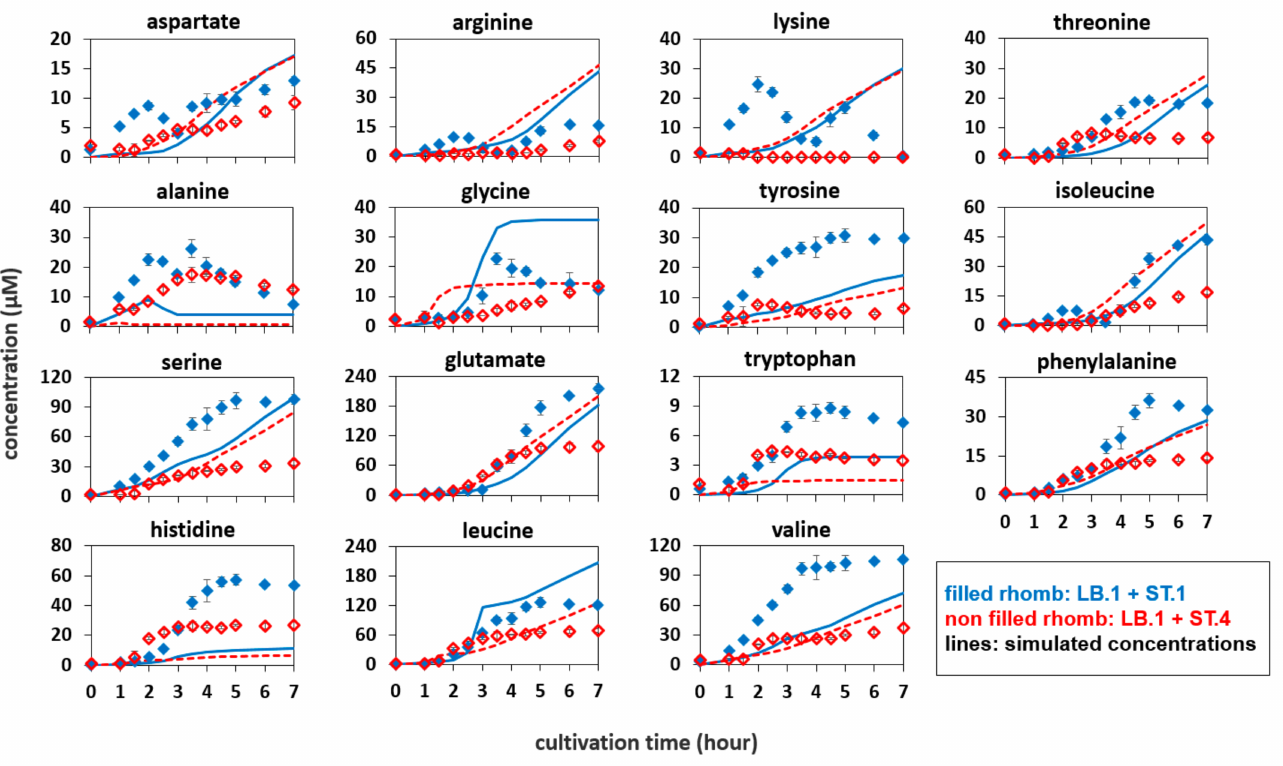
Figure 3. Amino acid concentrations in different co-cultures. (filled) Lactobacillus bulgaricus LB.1 co- cultured with proteinase-positive Streptococcus thermophilus ST.1 in synthetic medium supplemented with casein (SMcas). (non-filled) L. bulgaricus LB.1 co-cultured with proteinase-negative S. thermophilus ST.4 in SMcas. (line) Simulated amino acid concentration released from L. bulgaricus LB.1 in LB.1–ST.1 co-culture. (dashed line) Simulated amino acid concentration released from L. bulgaricus LB.1 in LB.1–ST.4 co-culture.